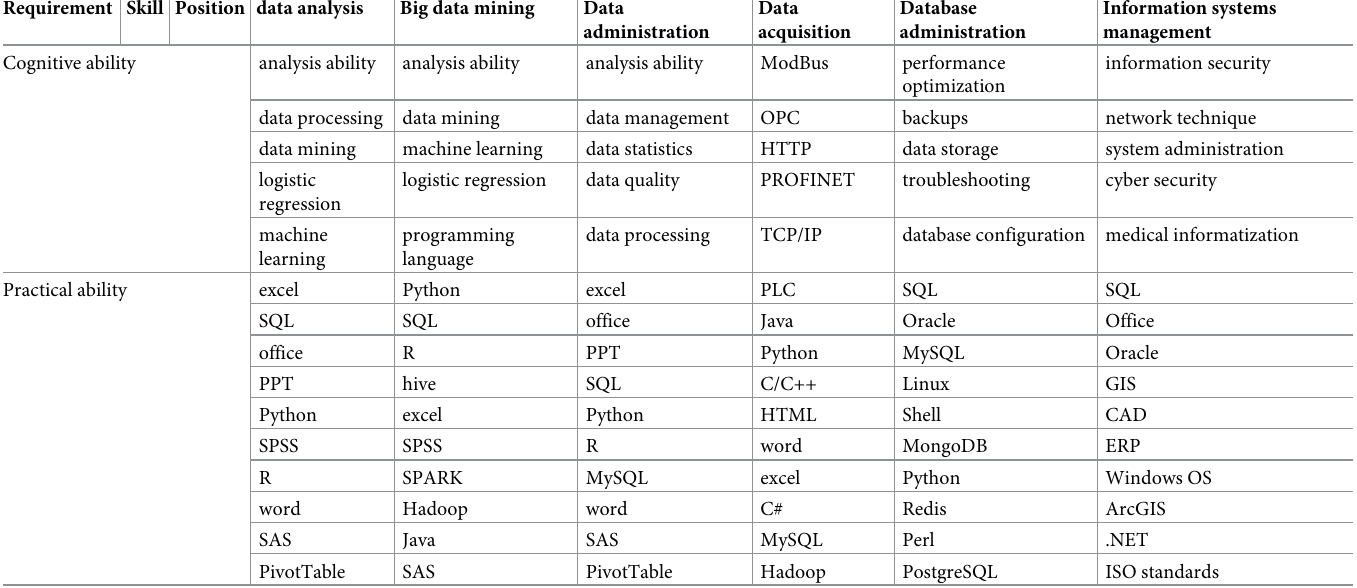
Table 3. Order of professional skill words in each